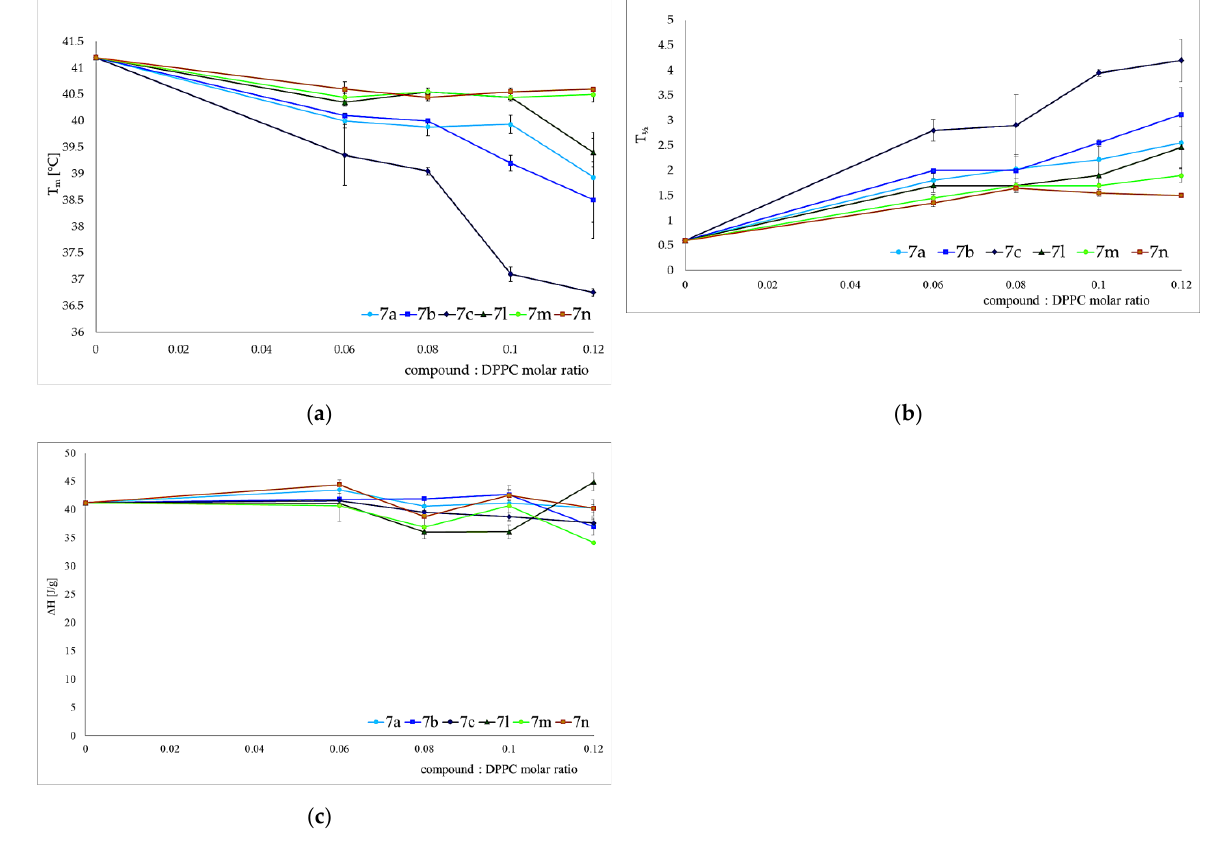
Figure 4. Influence of compounds on the parameters of 1,2-dipalmitoyl-s n -glycero-3-phosphatidylcholine (DPPC) main phase transition: temperature ( a ), peak width at half height ( b ) and enthalpy change ( c ). Bars represent standard deviations of four measurements. Where no error bars are shown, these were smaller than the symbols representing